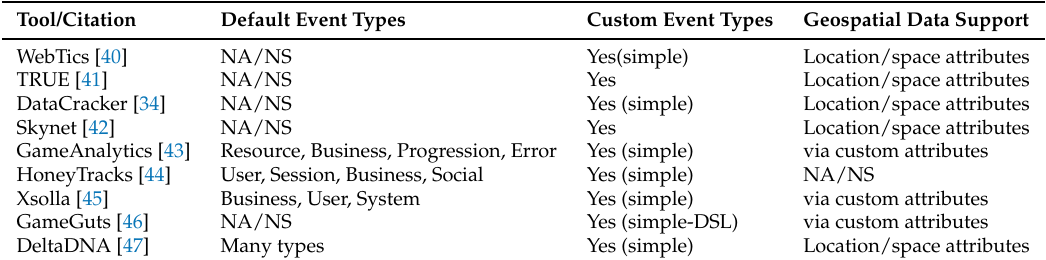
Table 4. Comparison of data representation related features among academic and commercial tools for game analytics. NA/NS=Not Applicable, Not Specified or